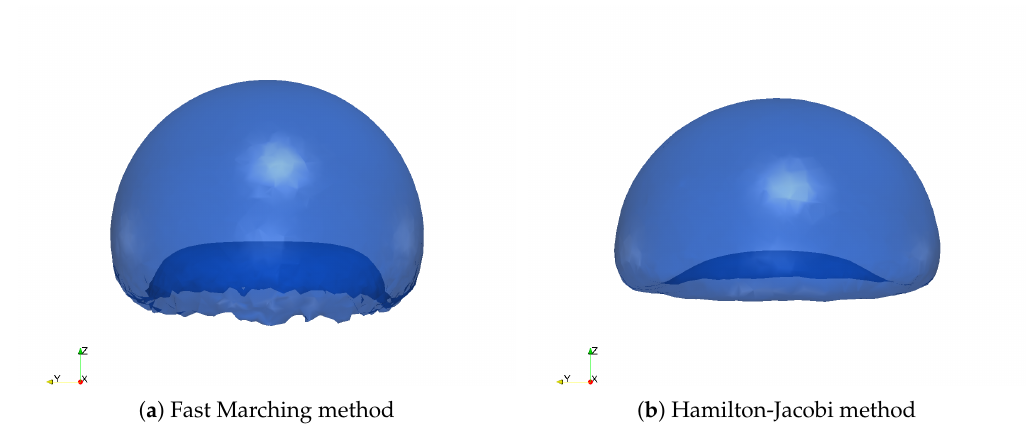
Figure 9. 3D shape at final time ( t = 3) in the x - y plane for test case 2 ( h = 0.0175).